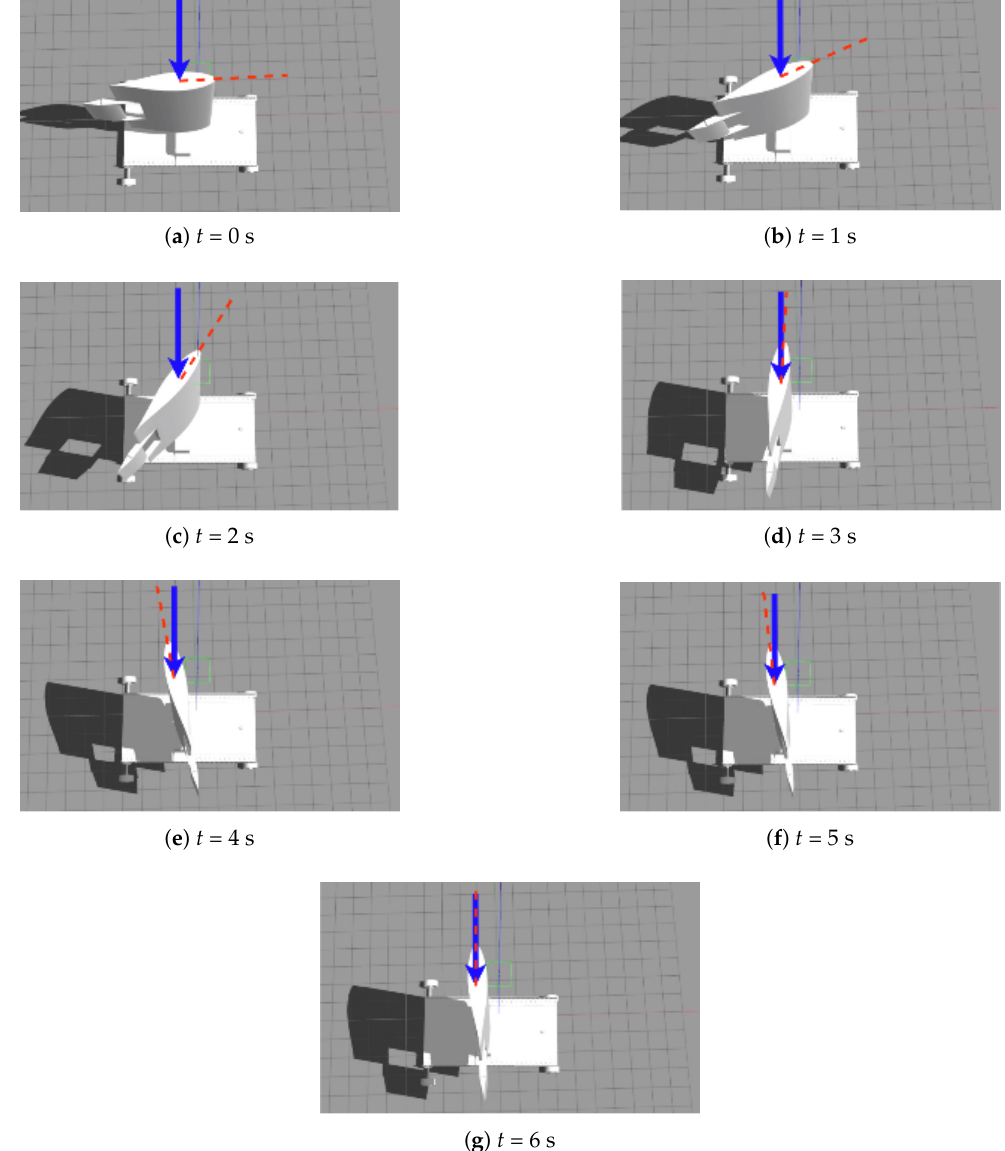
Figure 9. Wing sail alignment to the wind over time (10kn). Figure 10 displays the time response of the wing sail angle of attack. These results show that, when the wing and tail are aligned, the wing sail aligns automatically to the wind due to the yawing moment of the aerodynamics plugin. Although the wing sail takes identical time to stabilize with different wind velocities, the higher the wind velocity, the higher the